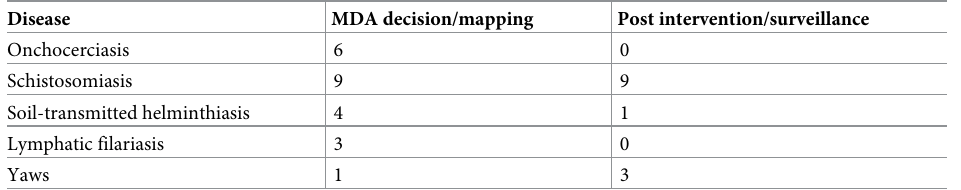
Table 3. Number of diagnostics per purpose of diagnostic/intended use. Disease